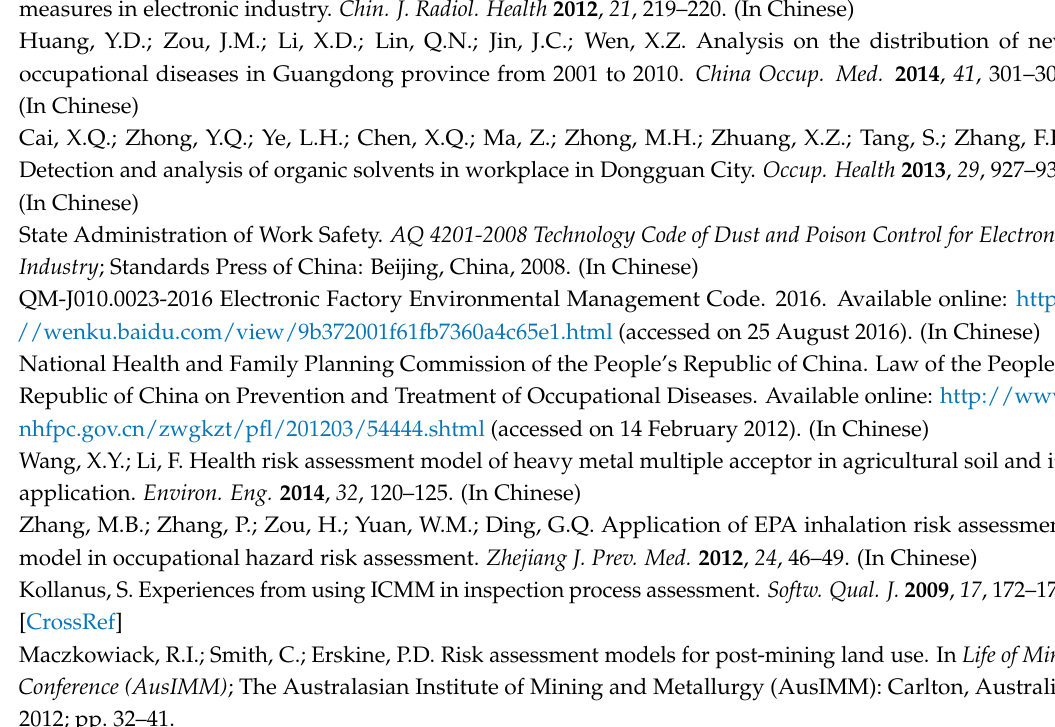
chemical hazards; Table S3: Classification and value of the ratio of the occupational exposure to chemical; Table S4: Classification and value of physical strength; Table S5: The on-site testing result of ammonia; Table S6: The chloride; Table S11: The on-site testing result of ethylene glycol; Table S12: The on-site testing result of phosphine; Table S13: The on-site testing result of boron trifluoride; Table S14: The on-site testing result of isopropanol; Table S15: The on-site testing result of